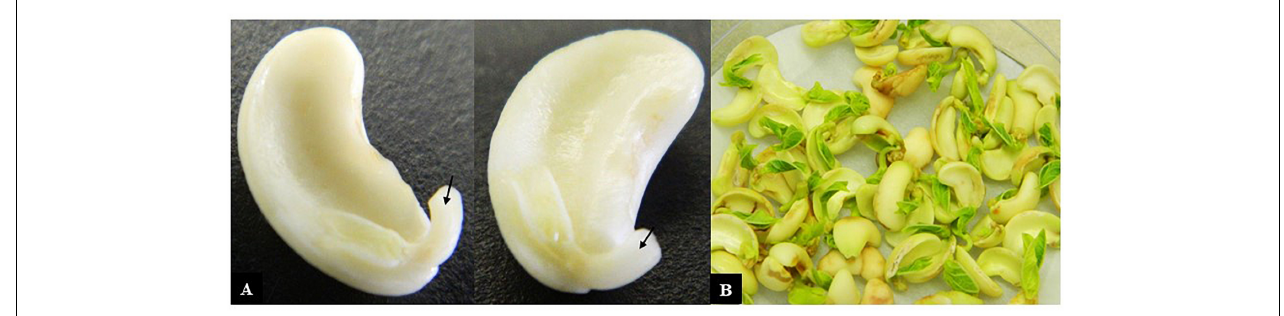
FIGURE 1 | Cowpea explants used for transformation. (A) Cotyledons with attached axes that had their radicle tips removed (arrows) ready for incubation with Agrobacterium and (B) after co-cultivation with Agrobacterium for 3 days.